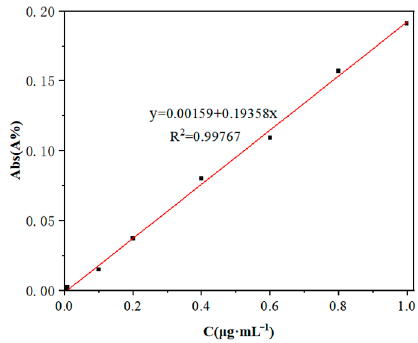
Figure 2. Standard curve of Cu 2+ .